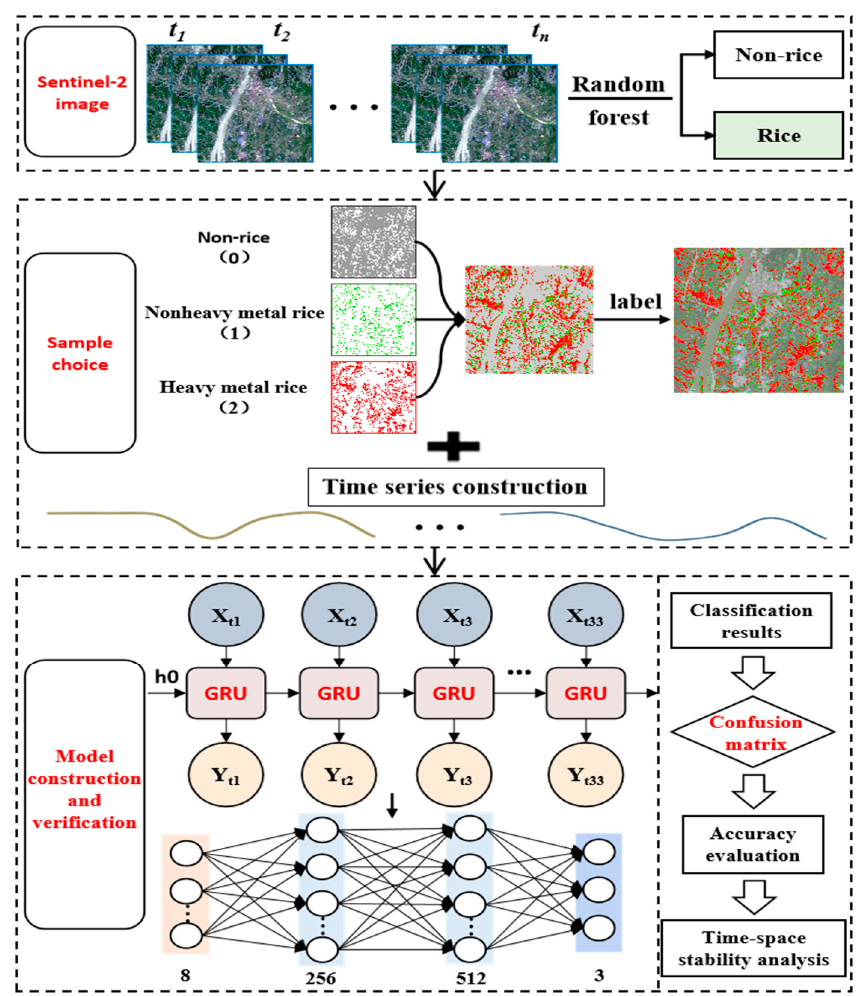
Figure 2. Flowchart of the GRU algorithm for the stress level monitoring of rice with heavy metal pollution. Table 1. Sensitive spectral parameters for monitoring heavy metal stress in rice. Bands